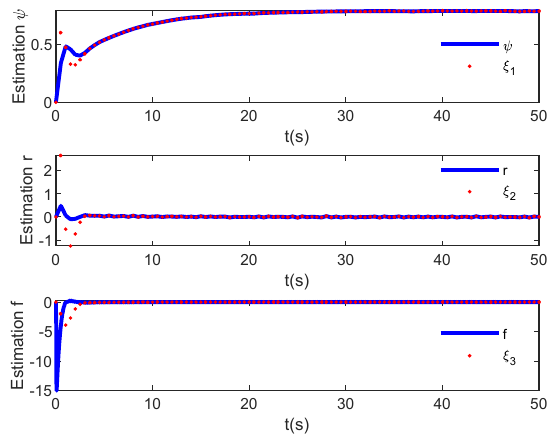
Figure 4. The estimation with ESO.